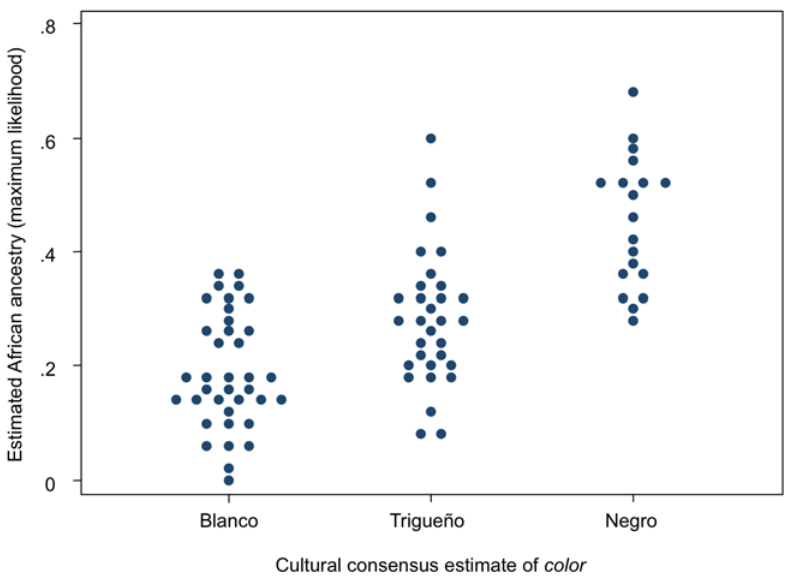
Figure 1. Relationship between individual level of African genetic ancestry and culturally ascribed color . Mean genetic ancestry varies across categories of color ( blanco versus triguen˜o: F [1,84]=12.04, p =.003; blanco versus negro : F [1,84]=73.65, p , .001; triguen˜o versus negro : F [1,84]=29.31, p , .001; Sˇida´k-correction for multiple comparisons). Individual African ancestry ranges from 0.08 to 0.69 in our sample. The distribution of African ancestry overlaps for blanco and triguen˜o across 40 percent of the observed range (0.08–0.35); for triguen˜o and negro across 48 percent (0.27–0.59); and for all three color categories across 12 percent (0.27–0.35).